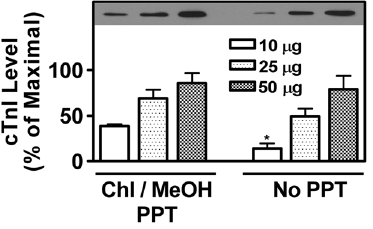
Figure 1. Chloroform methanol precipitation of proteins improves cardiac troponin I (cTnI) detection in Western blots. Cardiac left ventricular tissue from adult rats was homogenized as described in Methods. Homogenate protein (10–50 m g) was (left side) or was not (right side) subjected to chloroform/methanol precipitation prior to its resolution on SDSPAGE. Western blot analyses with anti- cardiac troponin I (cTnI) antisera were then conducted. A typical autoradiograph is shown (top). Histograms represent Mean 6 S.E. densitometry values, expressed as the percentage of maximal densitometry, from 4 independent experiments. Asterisk shown in the figure indicates statistically significant difference (p , 0.01) between 10 m g protein groups for chloroform/methanol precipitated (left) vs. not chloroform/methanol precipitated (right) proteins.